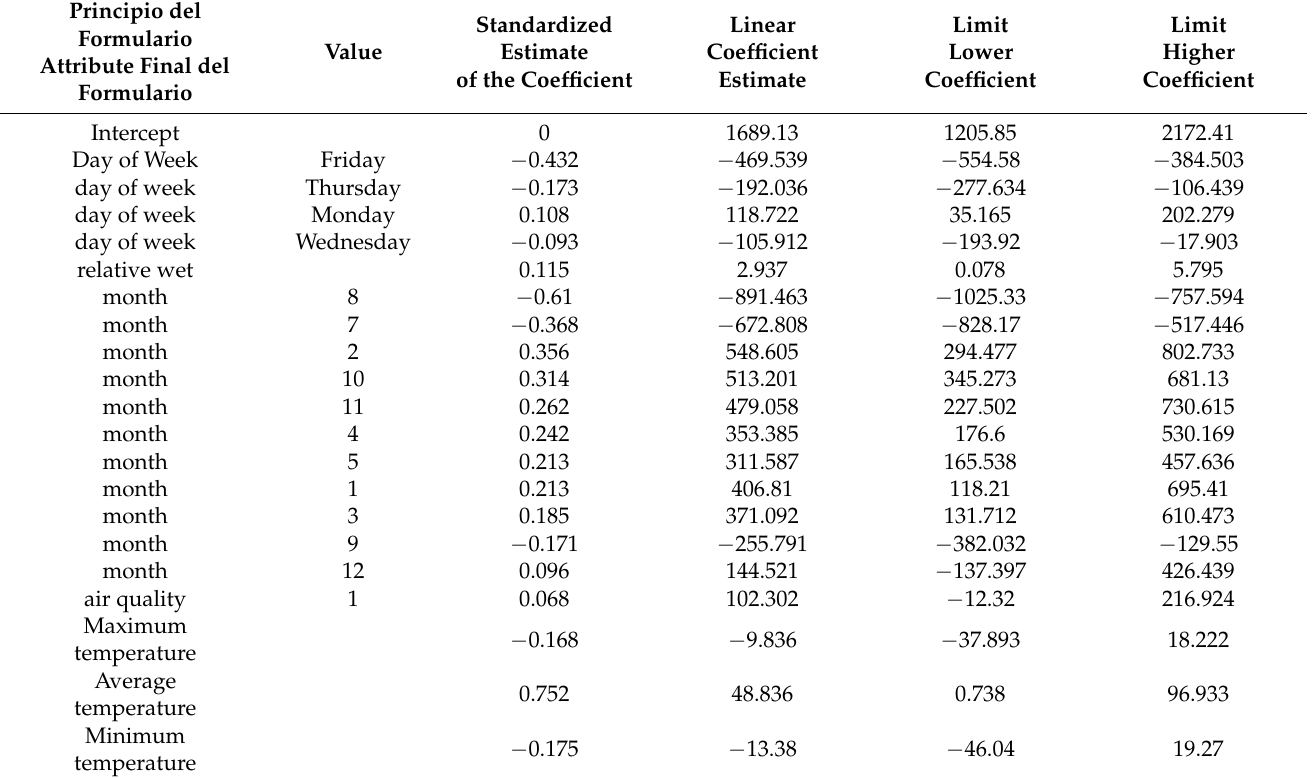
Table 5. Coefficient statistics for linear regression of the predictive